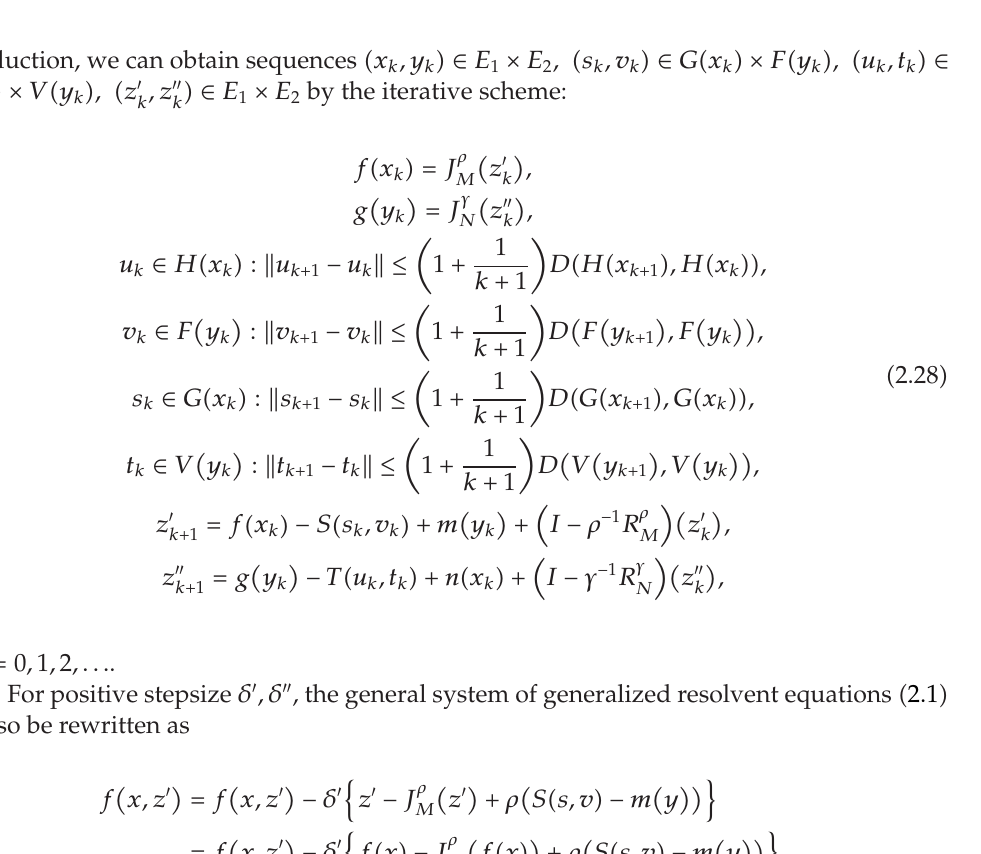
Algorithm 2.5. For given (cid:2) x 0 , y 0 (cid:3) ∈ E 1 × E 2 , (cid:2) s 0 , v 0 (cid:3) ∈ G (cid:2) x 0 (cid:3) × F (cid:2) y 0 (cid:3) , (cid:2) u 0 , t 0 (cid:3) ∈ H (cid:2) x 0 (cid:3)